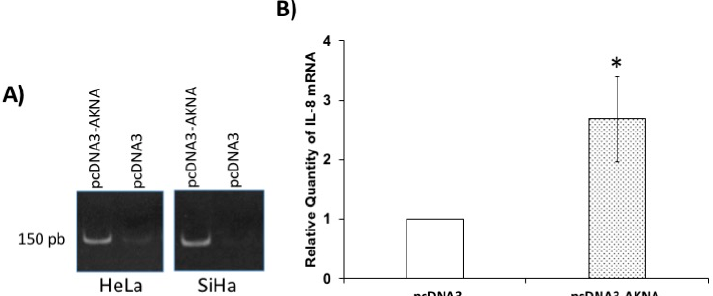
Figure 7. AKNA restoration induces expression of IL-8 in HPV positive cell lines. HeLa cells were transfected with pcDNA3- akna plasmid and after 24 h, total RNA was extracted using Trizol following the manufacturer’s instructions. Complementary DNA was synthesized and used as a template for IL-8 mRNA amplification using standard PCR ( A ) or relative quantification ( B ). AKNA transfected cells showed a remarkable increased in the IL-8 mRNA levels after AKNA expression. Data is presented as relative expression of IL-8 after normalizing with the HPRT1 expression ± SD. * p = 0.017 vs. pcDNA3 control. n = 4.